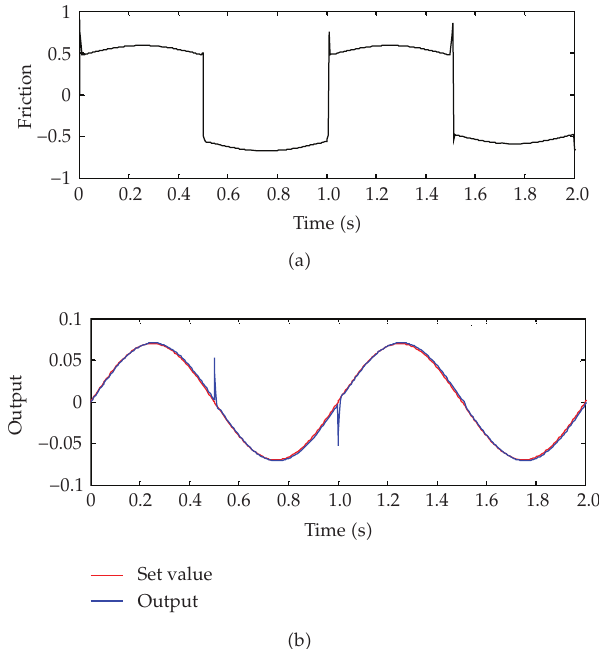
Figure 11: Reference signal is sinusoidal signal of